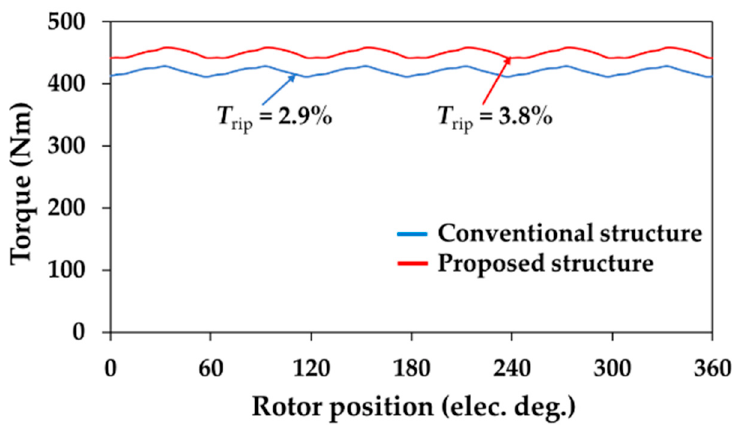
Figure 10. Output torques of two RPM-FS machines.